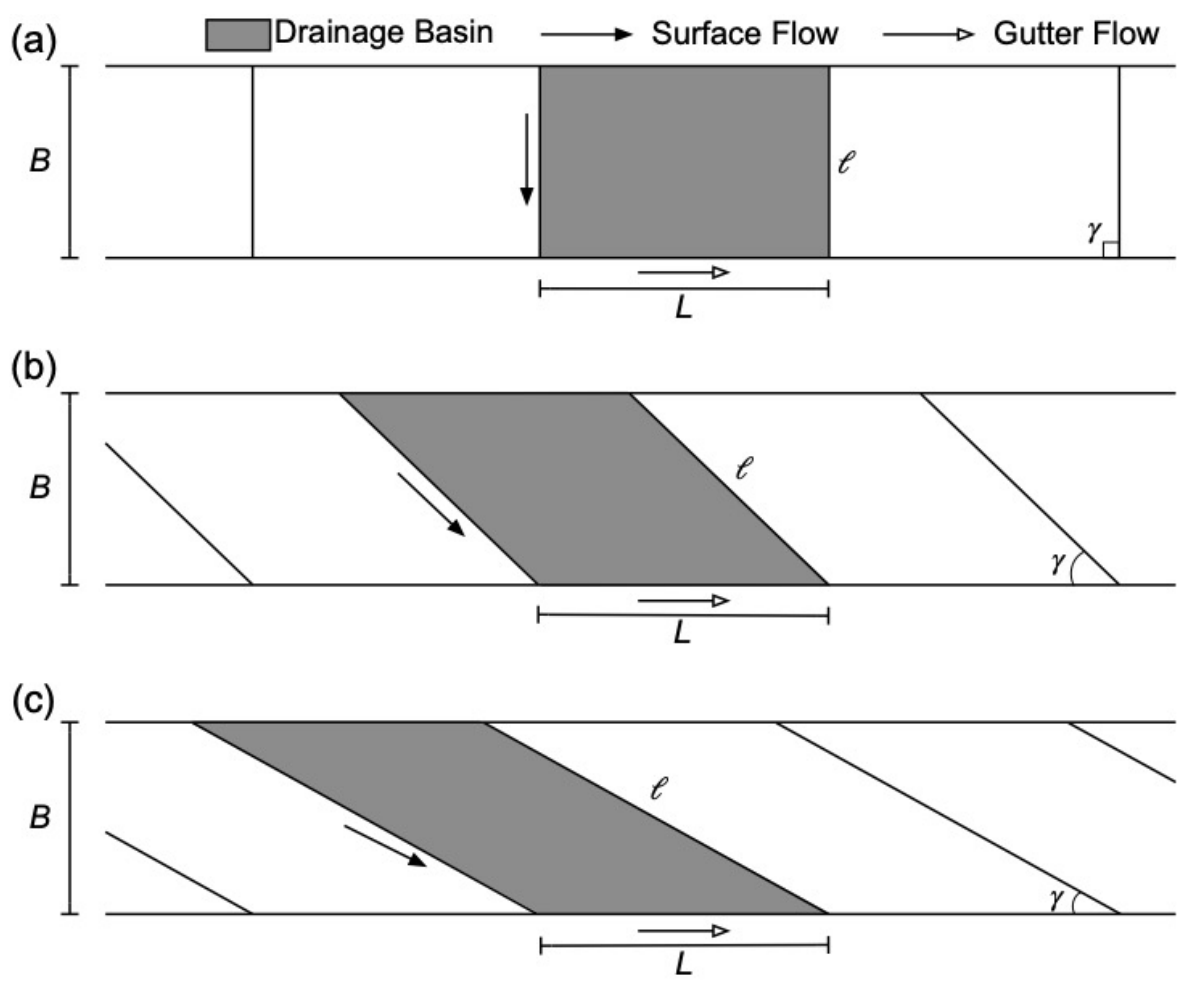
Figure 4. Changes in patterns of surface-runoff in a drainage basin considering the slope conditions of the road: ( a ) Simplified drainage basin ( (cid:96) = 6 m, γ = 90 ◦ ), ( b ) modified basin ( (cid:96) : 8.49 m, γ : 45 ◦ ) under the 2% longitudinal and 2% transverse slopes, ( c ) modified basin ( (cid:96) : 13.43 m, γ : 26.56 ◦ ) under the 4% longitudinal and 2% transverse slopes.